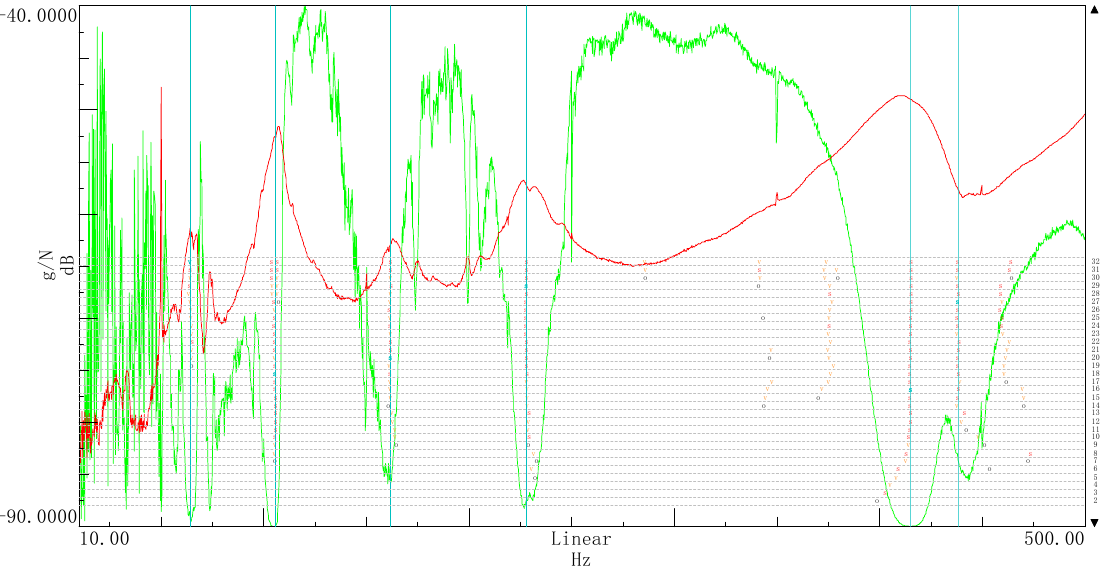
Table 2. Dynamics of the spindle of the percussion experimental machine tool.